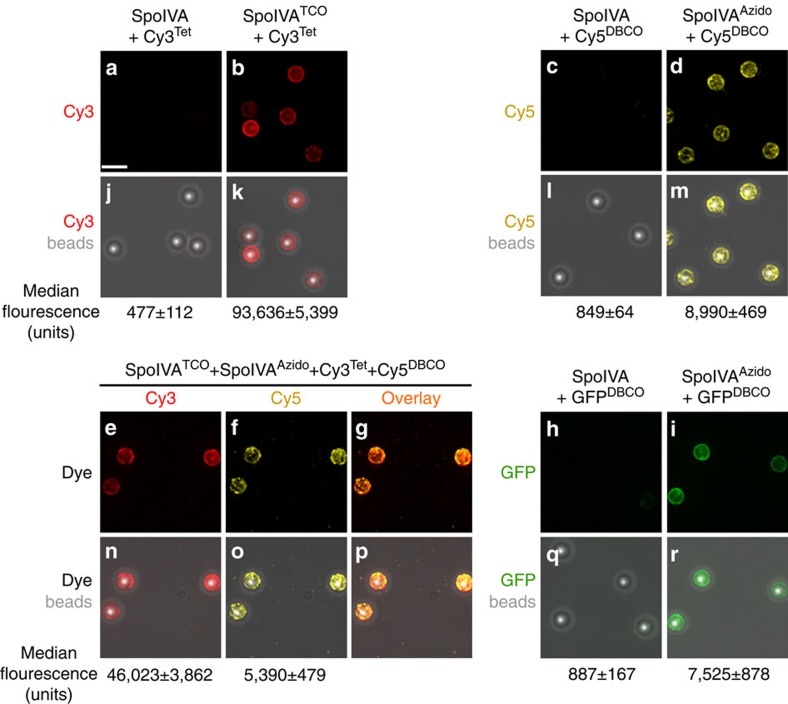
Covalent modification of the surface of SSHEL particles with small molecules or protein of interest.(a,b) Modification of the surface of SSHEL particles, with tetrazine-labelled Cy3 fluorophore, decorated with either (a) SpoIVA or (b) SpoIVA labelled with TCO-PEG3. (c,d) Modification of the surface of SSHEL particles, with DBCO-labelled Cy5 fluorophore, decorated with either (c) SpoIVA or (d) SpoIVA labelled with Azido-PEG3. (e–g) Stepwise modification of SSHEL particles, with Cy3Tet and Cy5DBCO, decorated with SpoIVATCO and SpoIVAAzido, viewed using the Cy3 filter (e) or the Cy5 filter (f). (g) Overlay of (e) and (f). (h,i) Modification of SSHEL particles, with DBCO-labelled GFP, decorated with SpoIVA (h) or SpoIVAAzido (i). (j–r) Overlay of DIC (grey) and fluorescence from (a–i), respectively. Median fluorescence intensity of decorated SSHEL particles (arbitrary units) is displayed below each panel. Scale bar, 3 μm. Median fluorescence intensities were determined from three replicate experiments; error is s.e.m. (n>40).